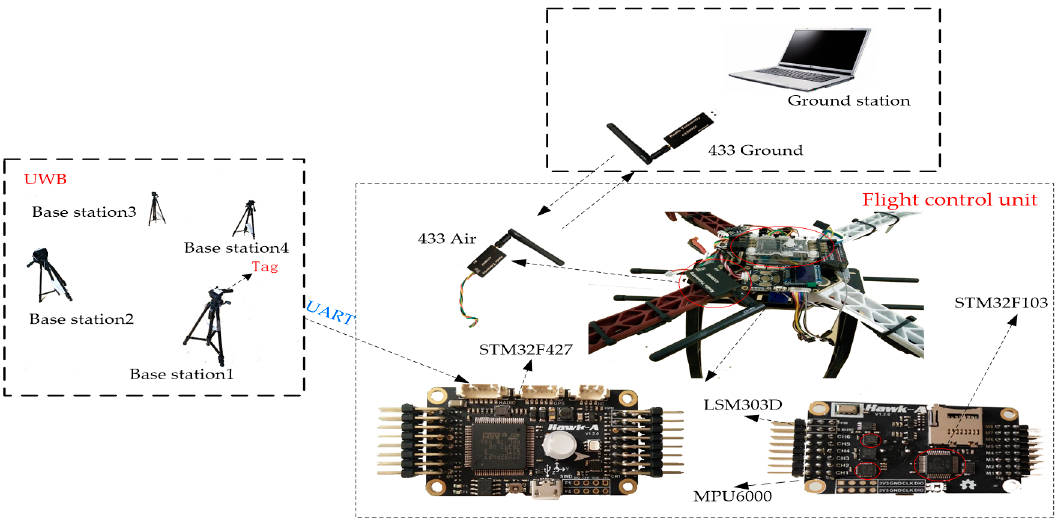
Figure 8. The experimental system.